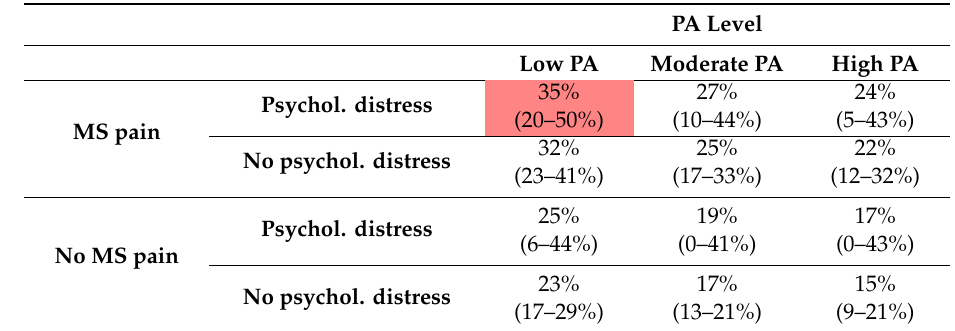
Table A2. Sensitivity analyses, risk matrix model for girls. Probability of Obesity (BMI ≥ 30) (percentage, (95% CI)) in young adulthood, with the reference group restricted to individuals within a normal weight range (BMI 18 · 5–24 · 9 kg / m 2